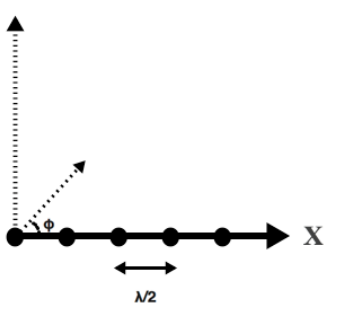
Figure 5. Uniform linear array of antenna elements placed along